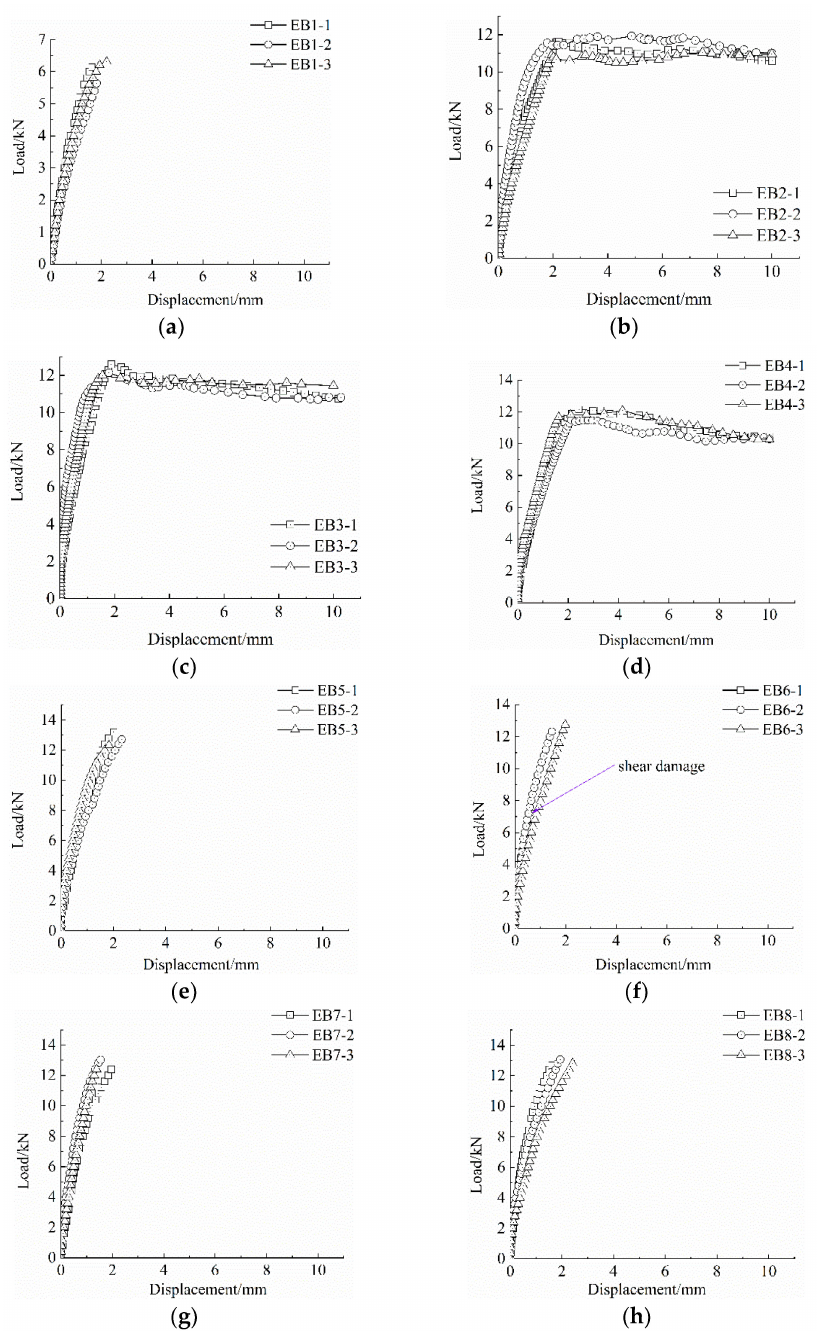
Figure 3. Bond–slip curve. ( a ) EB1, ( b ) EB2, ( c ) EB3, ( d ) EB4, ( e ) EB5, ( f ) EB6, ( g ) EB7, and ( h )